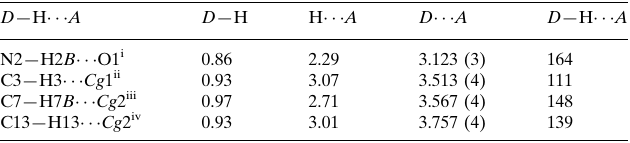
Hydrogen-bond geometry (A˚ , (cid:4)